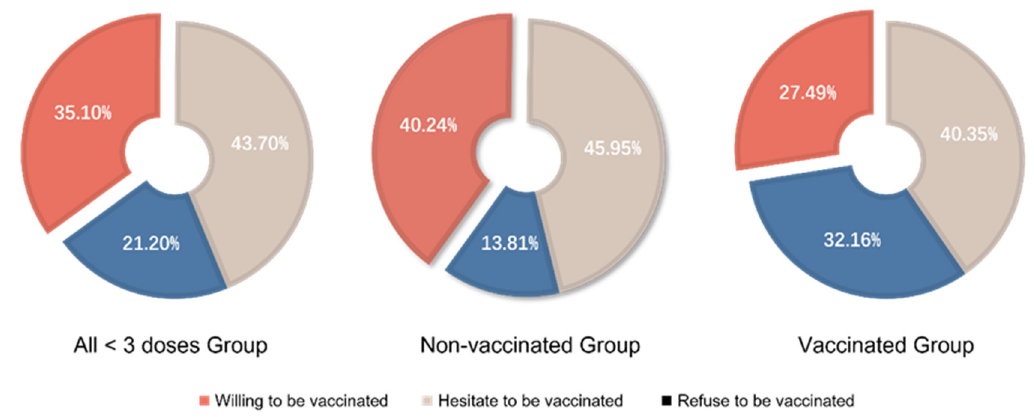
Figure 2. Willingness regarding future doses/boosters in all <3 doses group, non-vaccinated group and vaccinated group. Univariate and multivariate logistic regression analyses were performed to analyze